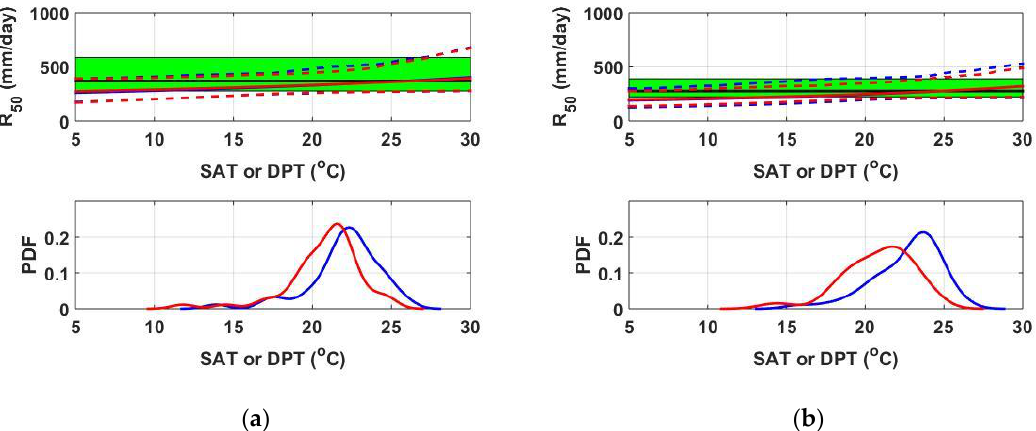
Figure 2. Co-variate-dependent rainfall quantile and its uncertainty at ( a ) the Chuncheon site and ( b ) the Cheonan site. The rainfall quantile 𝑅 50 corresponding to the return level of 50 years is shown. In the upper plot, the solid black line is the ensemble average of 𝑅 50 for the stationary model s , and the area painted in green is the 95% confidence interval. Blue lines were drawn from the non-stationary model 𝑛 1 . The red lines are the result of the non-stationary model 𝑛 2 . The empirical probability distribution of the observed co-variate is shown in the plot at the bottom. The distribution of surface air temperature (SAT) is indicated by the blue line and the distribution of dew point temperature (DPT) is indicated by the red line.